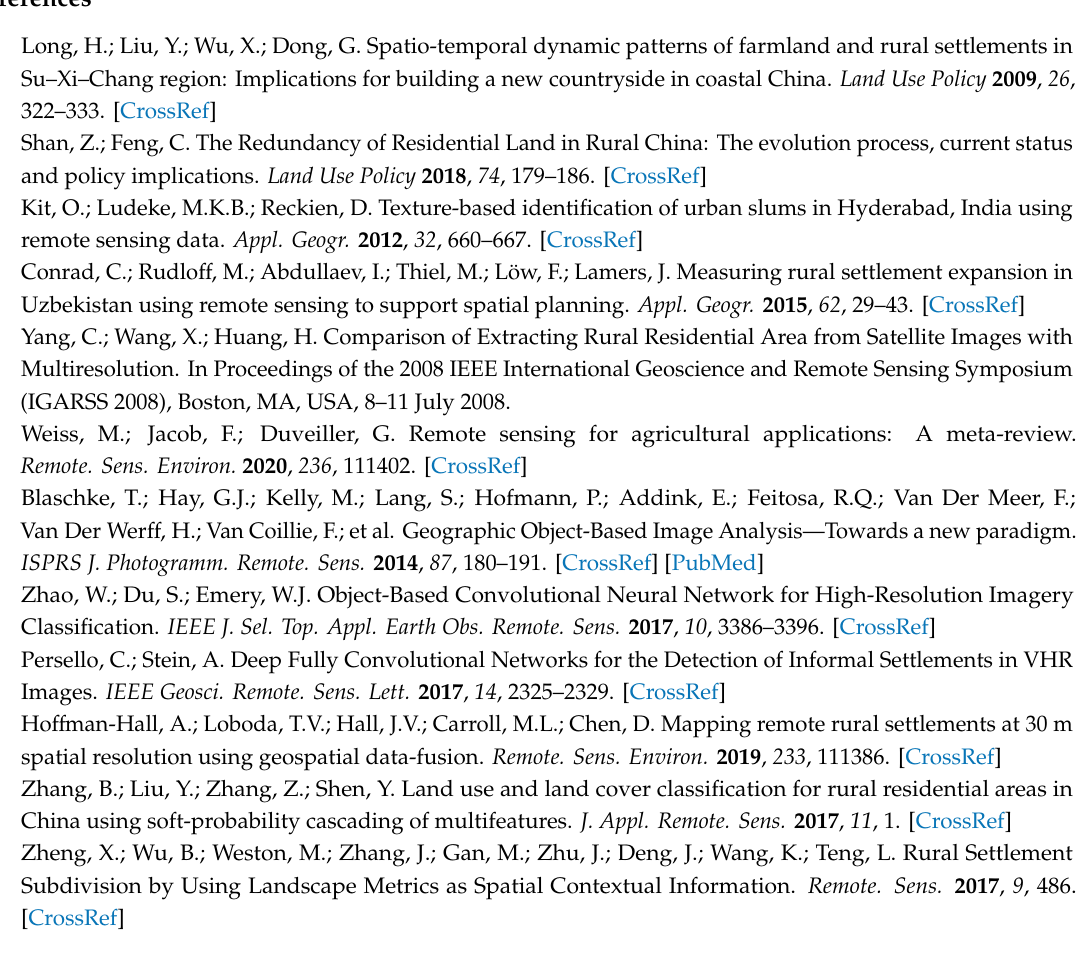
Table S1: Specification of our network